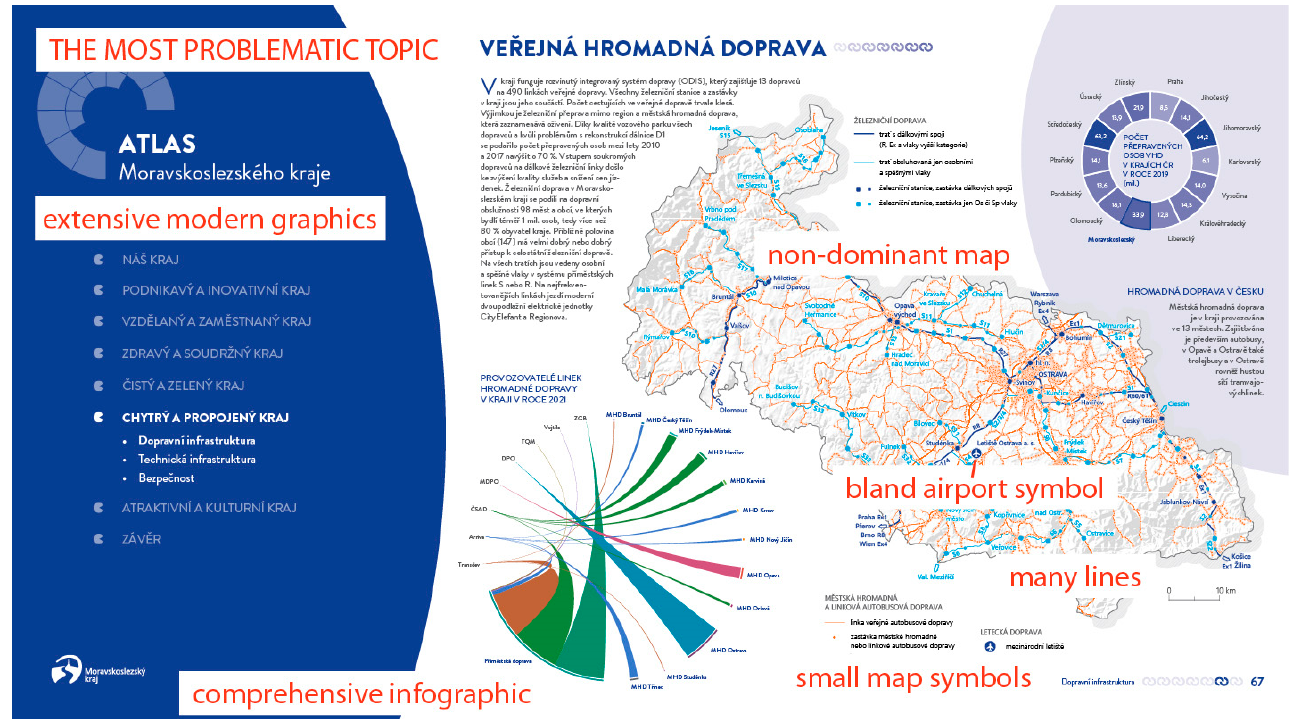
Figure 11. Issues found for the topic of public transport by participants.